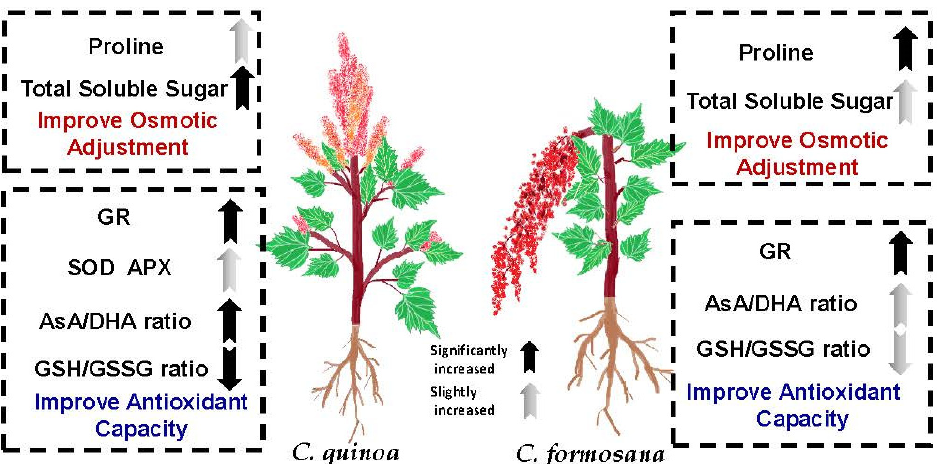
Figure 8. Different physiological mechanisms of drought tolerance between C. formosana and C. quinoa.